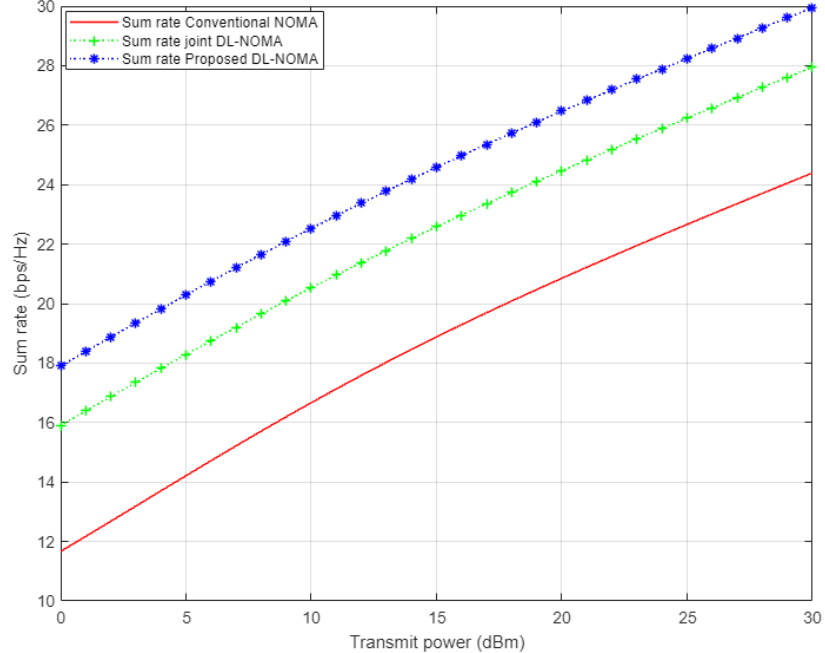
Figure 6. Sum rate vs. power for conventional NOMA, joint DL-NOMA, and proposed DL-NOMA (Rayleigh Channel).